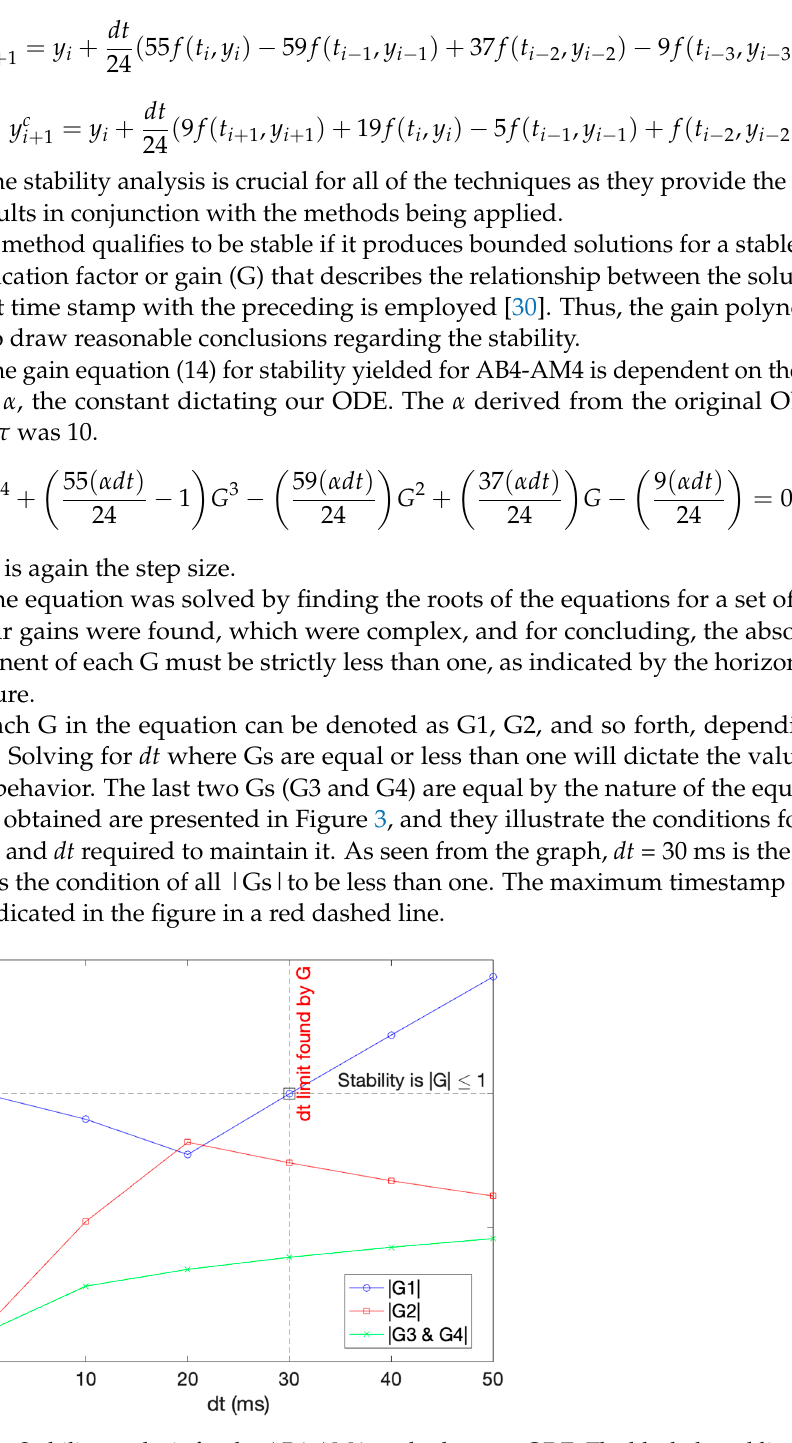
Figure 3. Stability analysis for the AB4-AM4 method on our ODE. The black dotted line represents the G limit that must be abided by, and the red vertical line shows the dt found abiding by the limit.